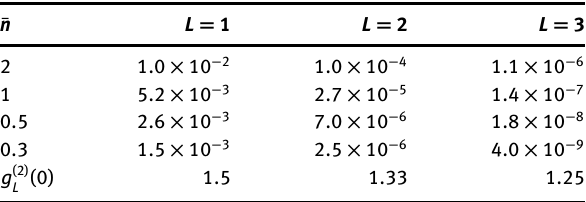
Table 1: The estimated probability of plasmon subtraction and the corresponding degree of second-order coherence g (2)